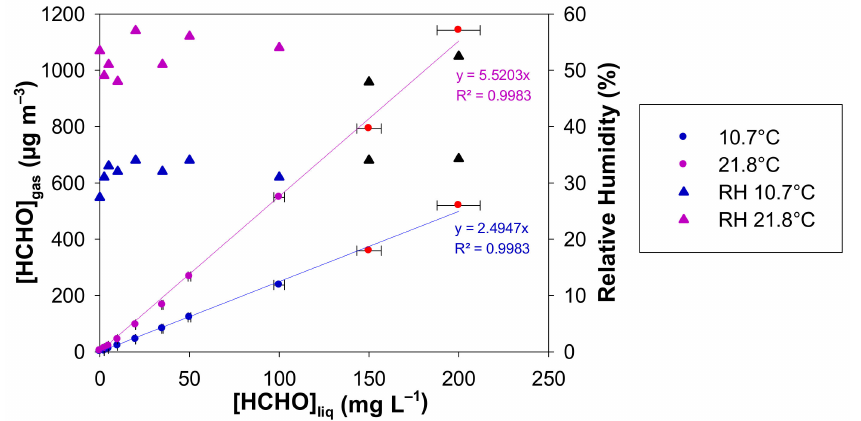
Figure 6. Generated concentration of gaseous formaldehyde and relative humidity obtained with a formaldehyde analyser ( µ F1, Chromatotec, Val-de-Virv é e, France) vs. the liquid formalde- hyde concentration for two different temperatures (10.7 ◦ C in blue and 21.8 ◦ C in purple), [HCHO] liq = 0–200 mg L − 1 , F gas = 50 mL min − 1 , L = 7 cm, photomultiplier gain = 50%. The hor- izontal error bars correspond to the uncertainties calculated from the preparation of the liquid formaldehyde solution. The vertical error bars correspond to two times the standard deviation, but they are too small to be visible. Red circles and black triangles mean that the generated gaseous formaldehyde mixture has been diluted prior to analysis, so a correction has been applied to obtain the real values of [HCHO] gas and